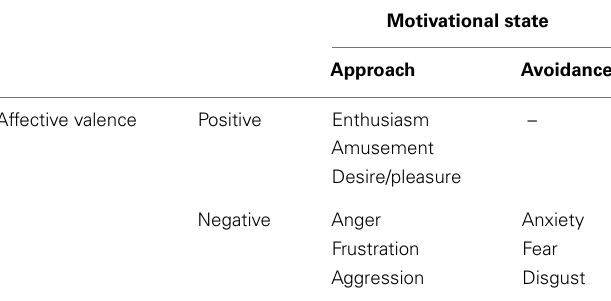
Table 2 |Affective valence × motivational